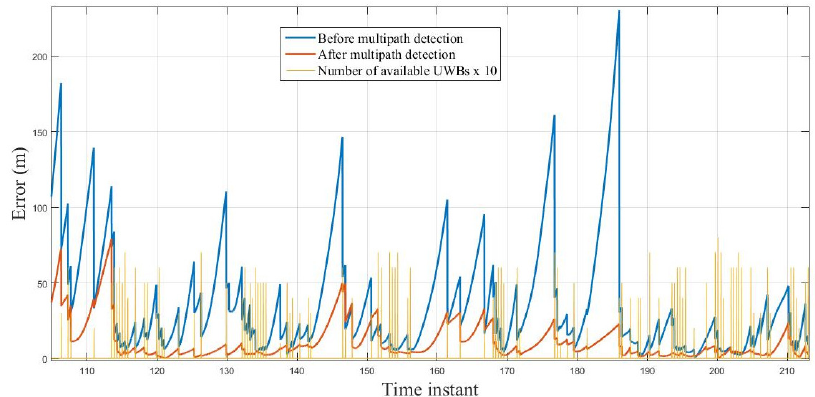
Figure 24. View2: Zoomed view of Figure 22.